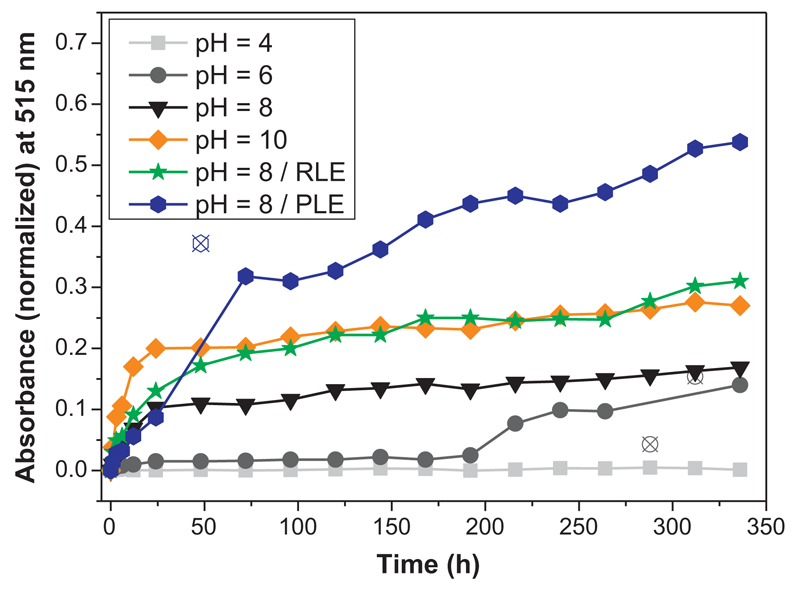
(Normalized) Absorbance at 515 nm for the quantification of the released dye
Eosin B during degradation studies of crosslinked
pEtOx100-stat-pNonOx50-stat-pBu⁼Ox30
at various conditions.